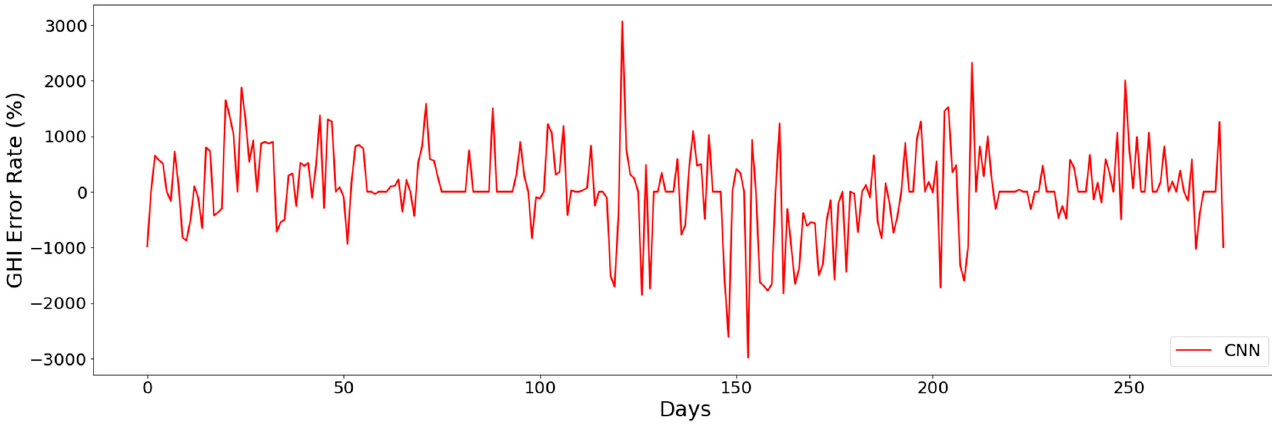
Figure 8. CNN (DL) error frequency rate.